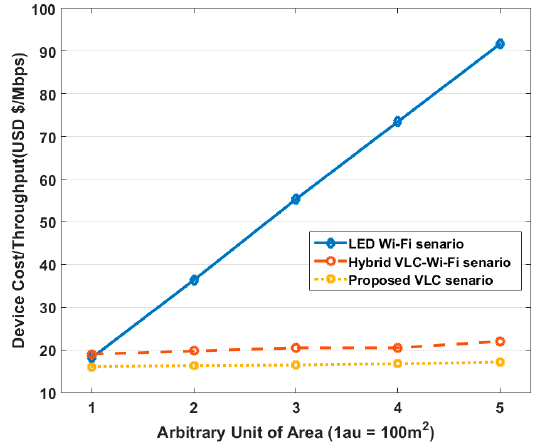
Figure 7. Device cost comparison of architecture 1 for all three systems.